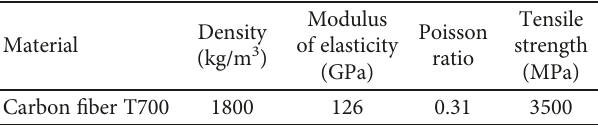
Figure 12: Finite element model of storage tank and microsatellite with the deployment mechanism. Table 17: Material parameters of the deployment mechanism.